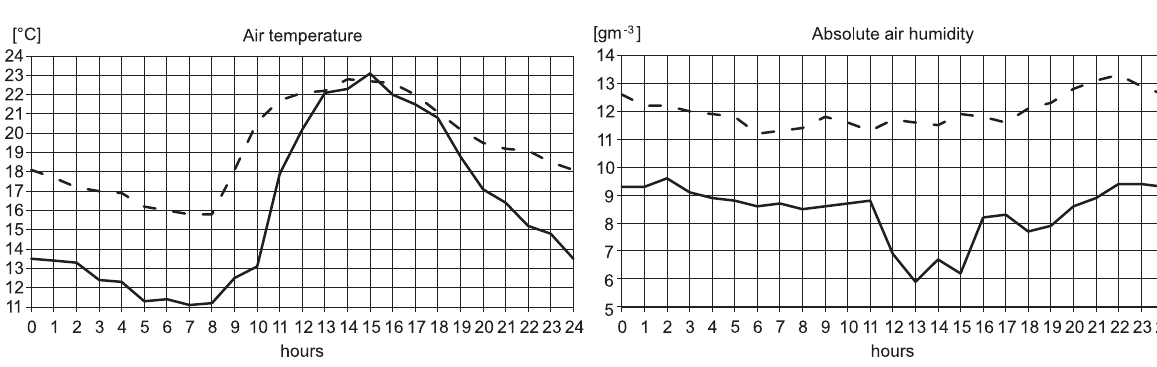
Fig. 2. The daily course of the mean air temperature and absolute air humidity in Laâyoune on 03–12.03.2010 (dashed line) and 25.02–01.03.2012 (solid line)